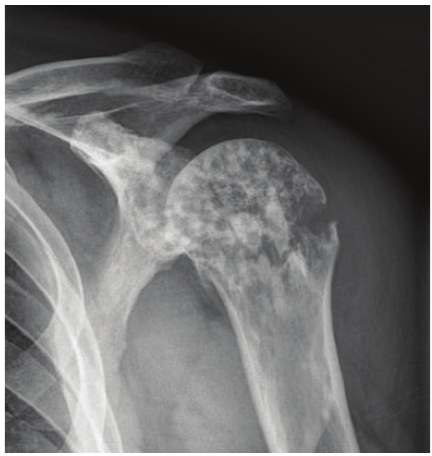
Figure 1: Radiograph of the left shoulder showing a metaphy- seal proximal slightly displaced fracture of the humerus and a heterogeneous bone structure with epiphyseal and metaphyseal predominance.